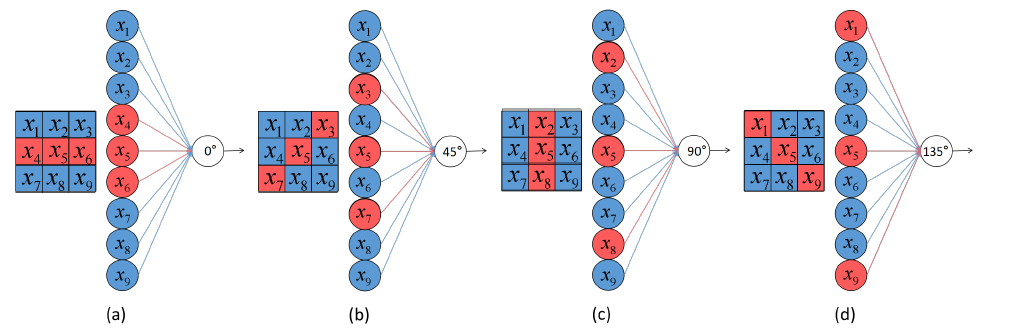
Figure 4. Weight of different pixels in the receptive field of a single neuron and shown as MP neurons. ( a ) 0-degree neuron; ( b ) 45-degree neuron; ( c ) 90-degree neuron; ( d ) 135-degree neuron.